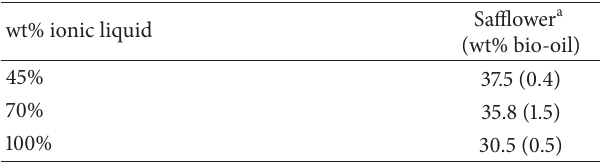
Table 5: Bio-oil yields relative to weight of whole seed from saf- flower whole seed treated with the cosolvent [C2mim][Ac]-MeOH at 120 ∘